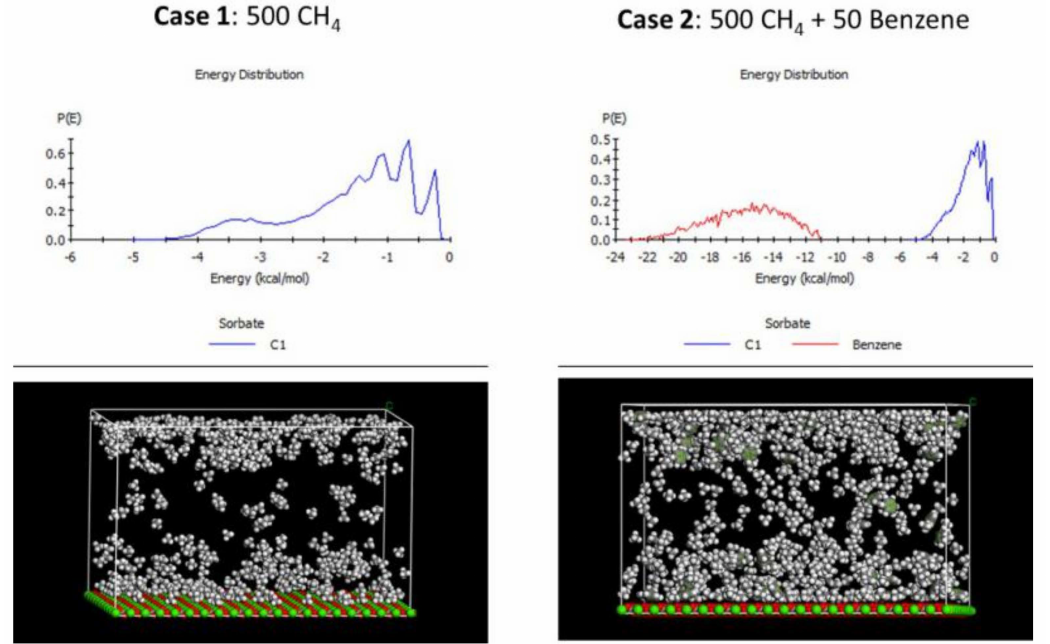
Figure 10. Calculated adsorption energies (kcal/mol) on a calcite surface in a pore